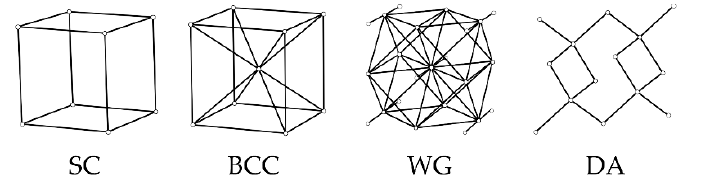
Figure 2. Unit cell geometry: simple cubic (SC), body-centered cubic (BCC), modified Wallach-Gibson (WG), and diamond (DA).